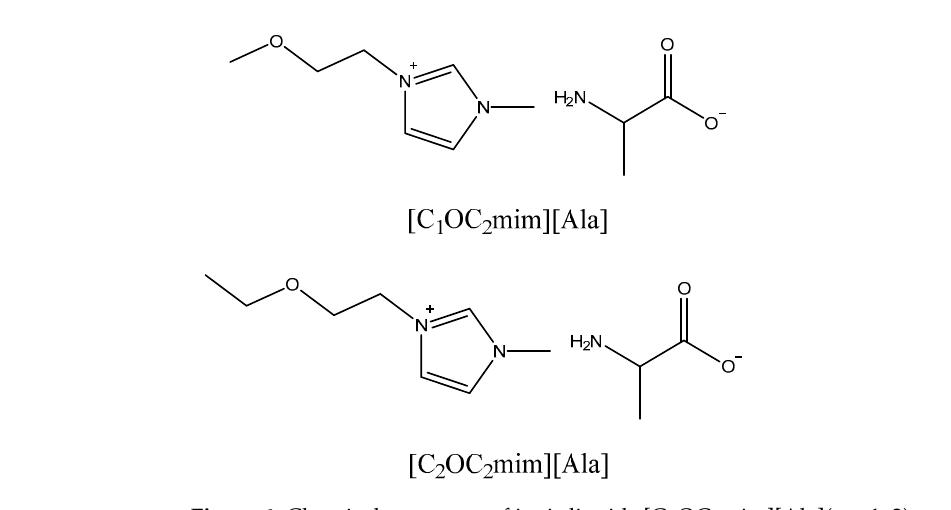
Figure 6. Chemical structures of ionic liquids [C n OC 2 mim][Ala]( n = 1,2).